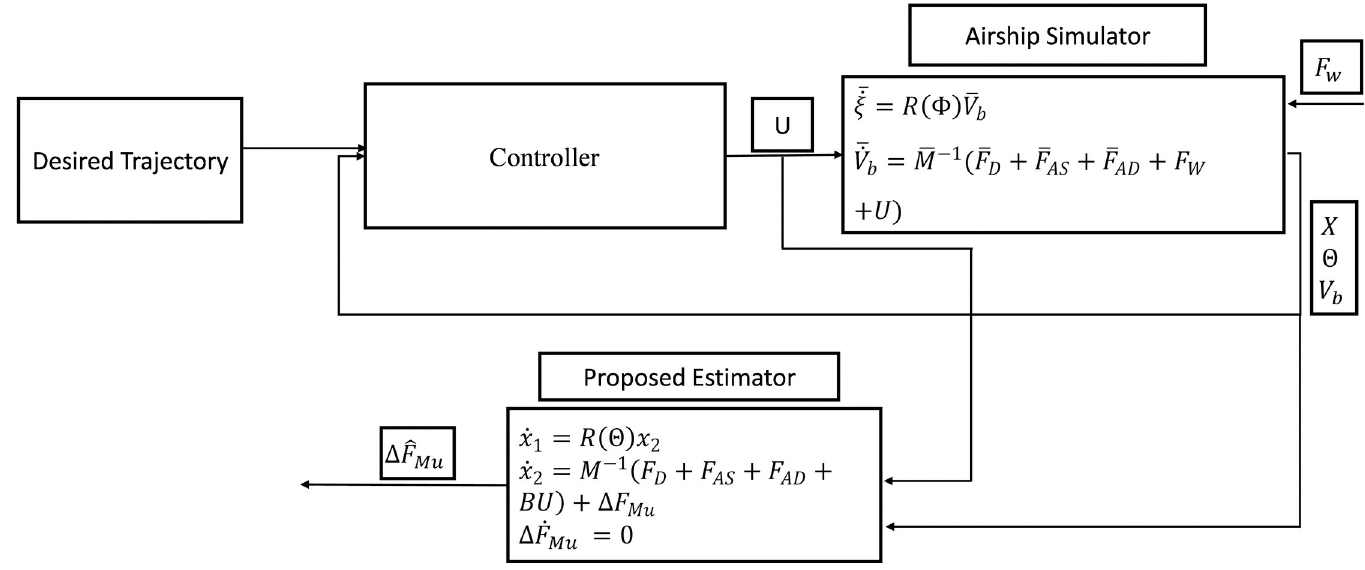
Fig 2. Generalized flowchart for the